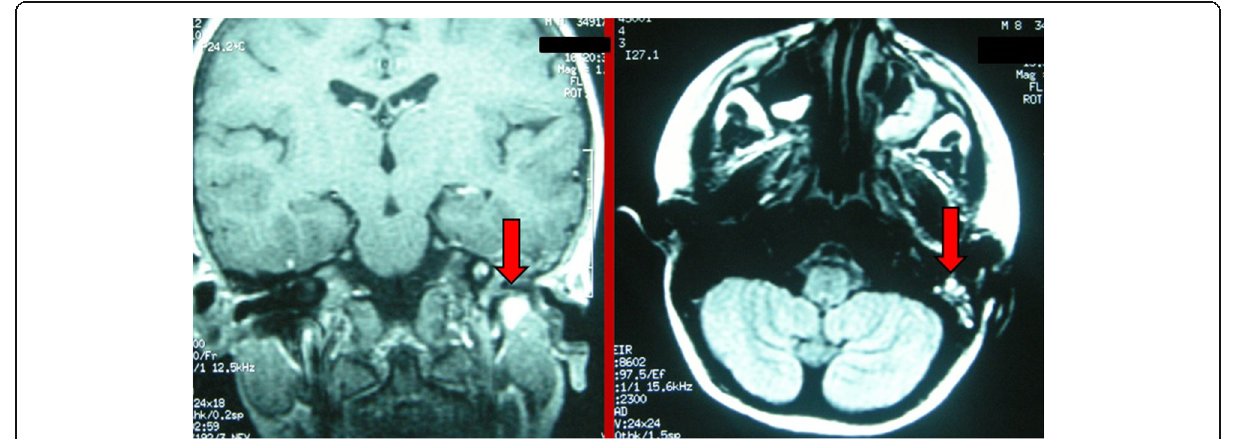
Fig. 3 T1-weighted coronal section and T2-weighted axial section of temporal MRI: arrows show a contrast-enhancing